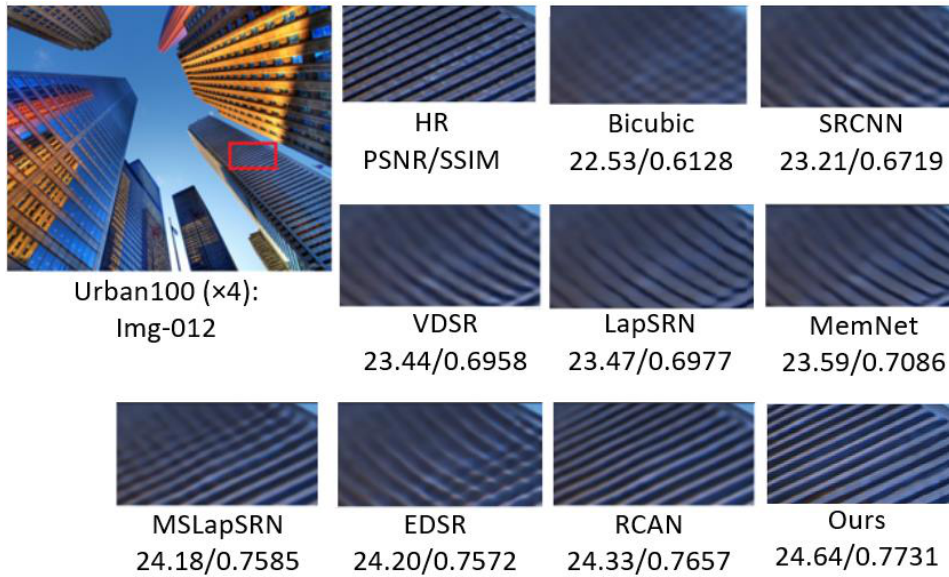
Figure 13. Visual comparison of image “Img-012” at × 4 scale on the Urban100